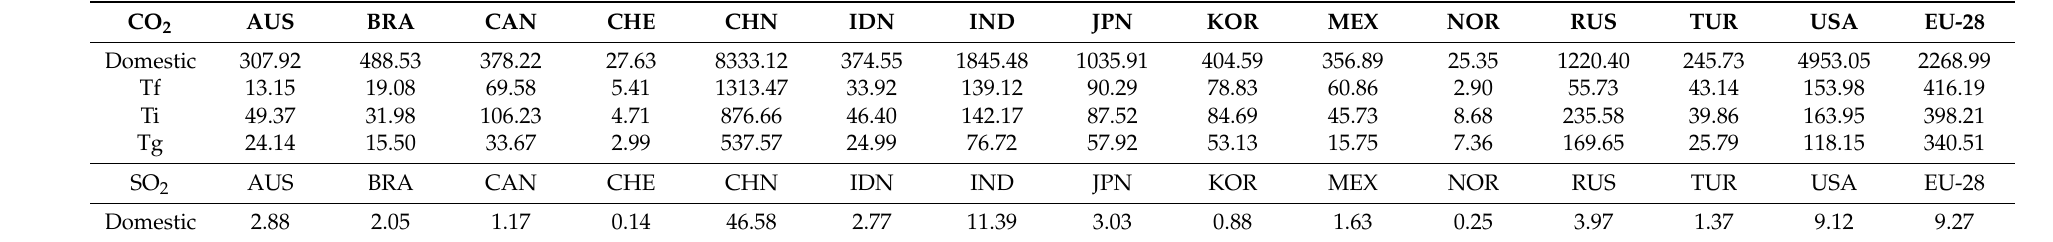
Table A4. The situation of global pollutant emissions in 2014.